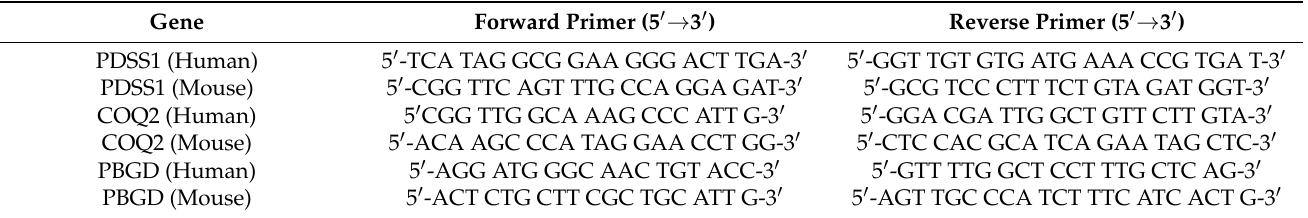
Table 1. List of primer sequences used for